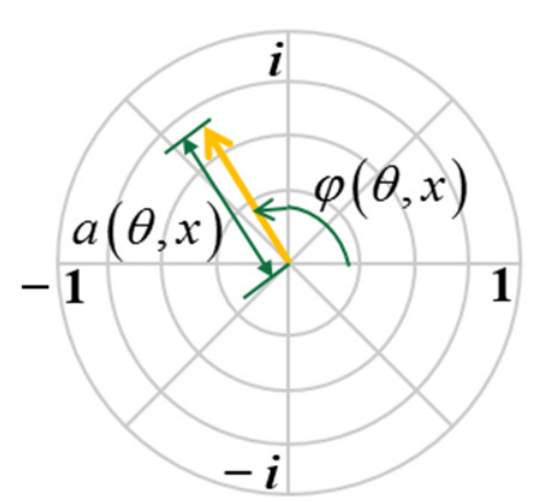
Figure 4. Polarization phasor representation.